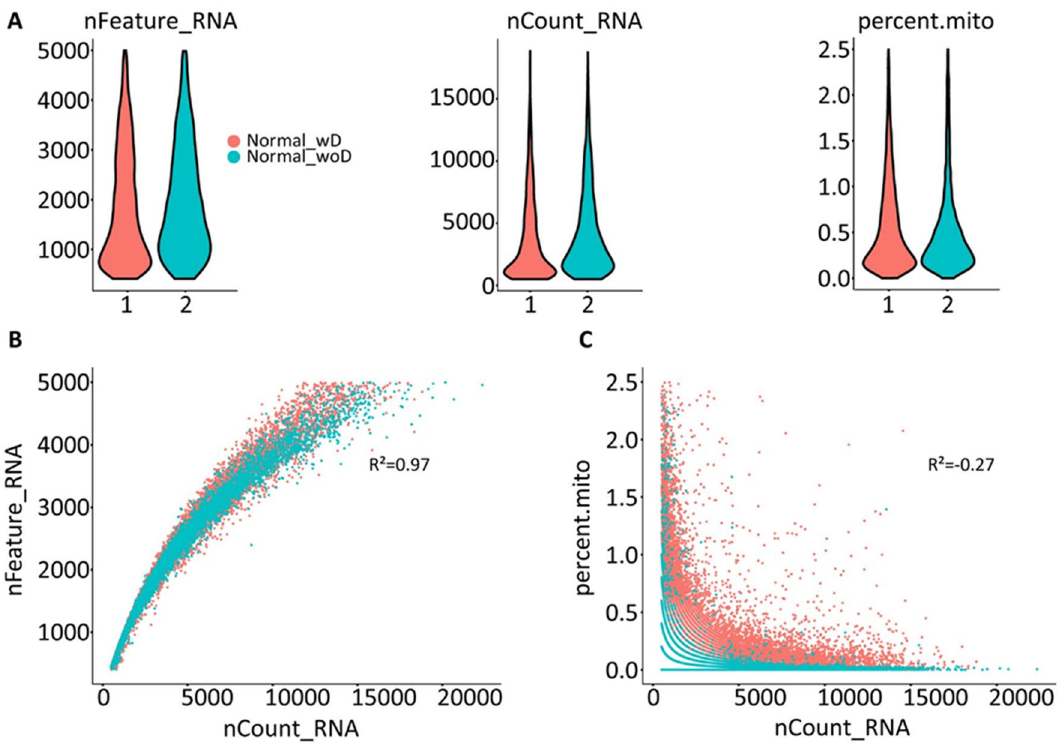
Figure 5. Comparative sequencing performance metrics for single nuclei isolation by traditional methods. Sequencing quality control metrics comparing a representative normal sample isolated ( A ) using douncing (1) and our described method without douncing (2). Dot plot representation of each group depicting the relationship of the ( B ) number of genes detected (y-axis) against the total number of RNA reads (x-axis) (R 2 = 0.97) and ( C ) percent of mitochondria reads (y-axis) against the total number of RNA reads (x-axis) (R 2 = −